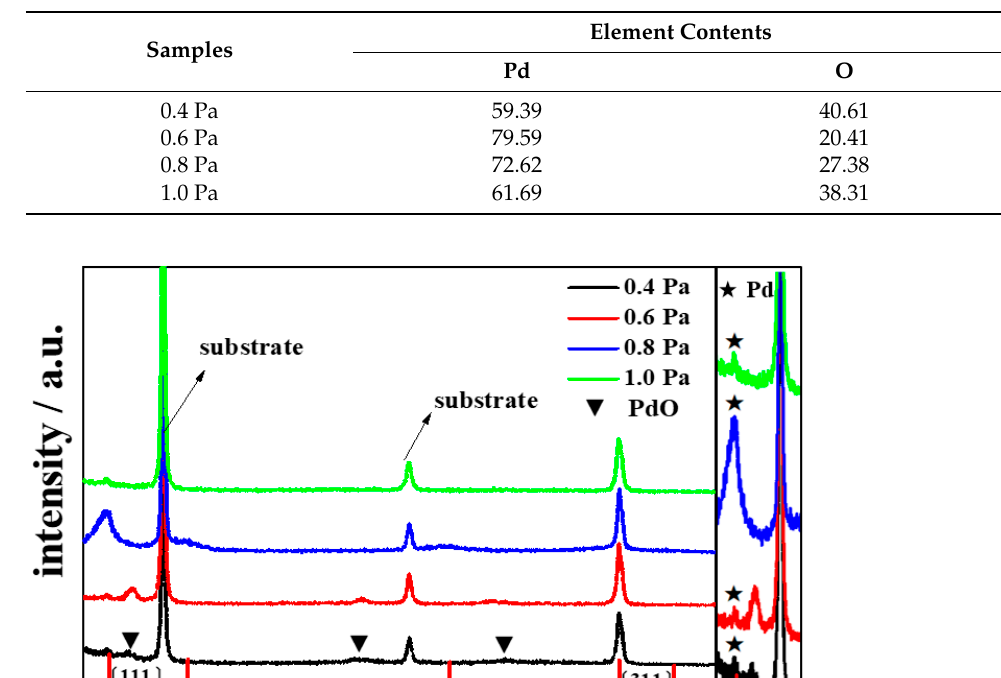
Table 1. Surface chemical composition for samples before the tests: the values are in atomic percent (at. %).